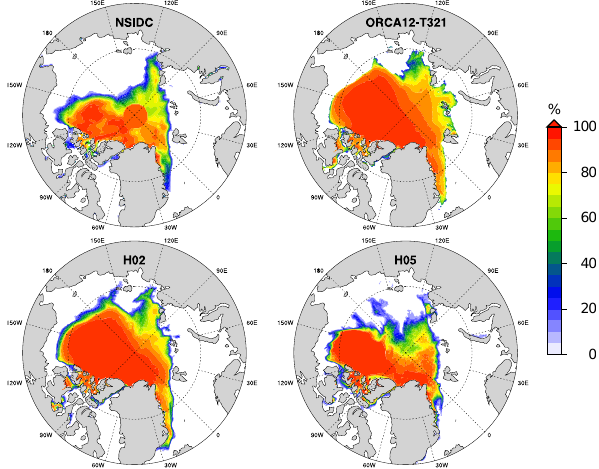
Figure 12. Monthly time series of total ice extent in the Arc- tic obtained from satellite observations (black, described as SMMR + SSM/I), the ORCA12 T321 run from Mercator Océan (blue) and CREG12 hindcasts H02 (green) and H05 (red). The top panel shows all months, while the bottom panel retains only September from each year.